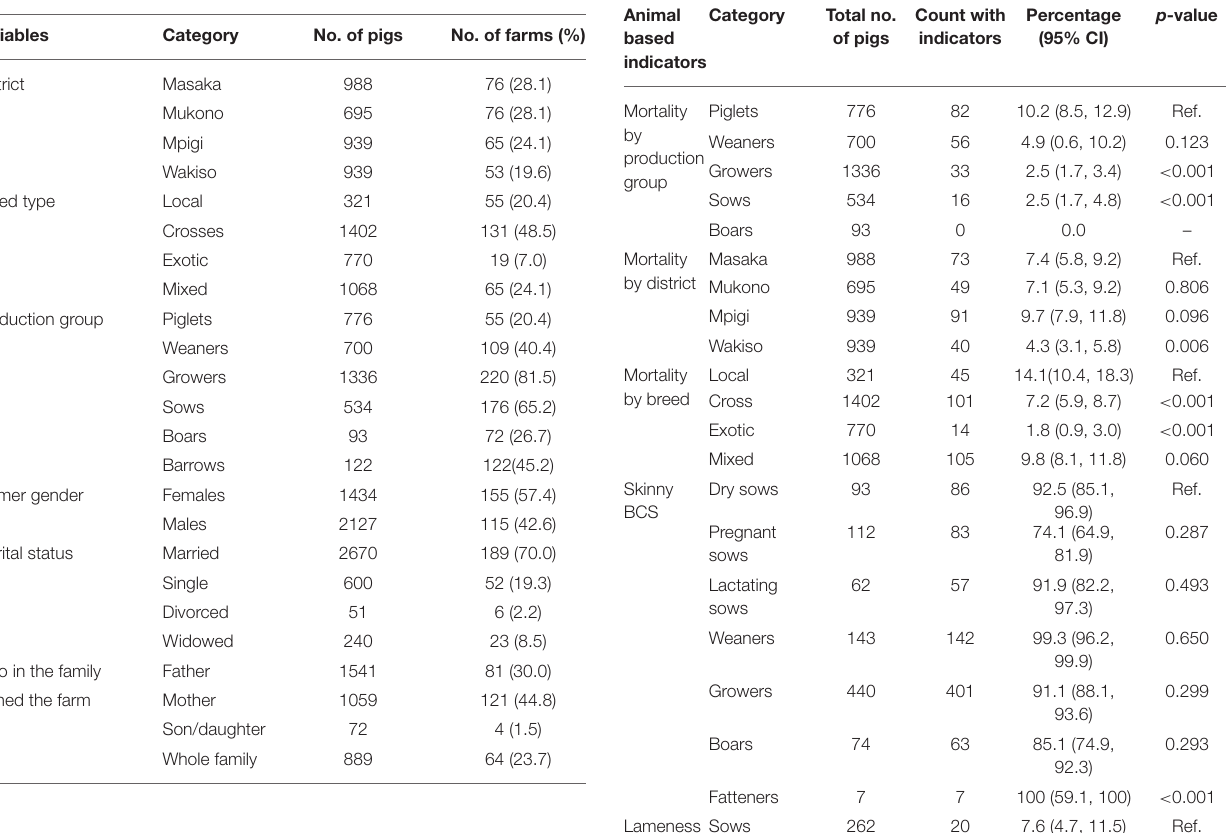
TABLE 3 | Pig class vs. herd size in surveyed districts. District Pig class